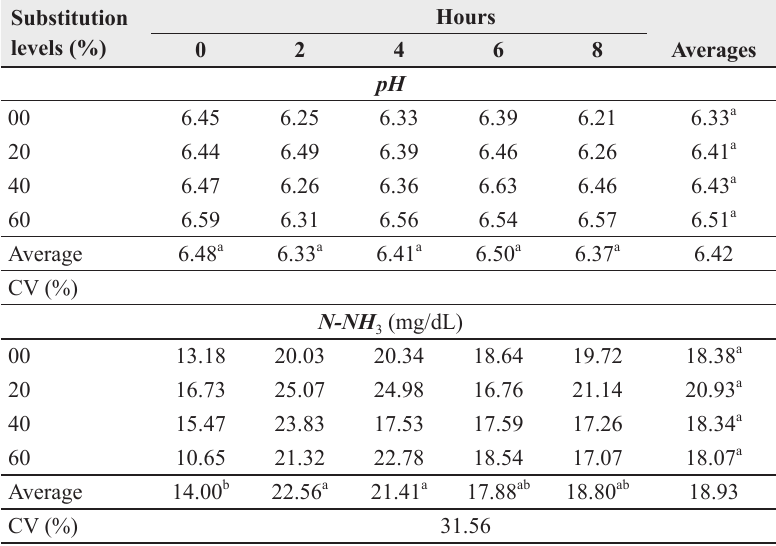
Averages of pH and NH -N ruminal, for steers supplemented with sunflower 3 crushed in a partial replacement of soybean meal, and its coefficient of